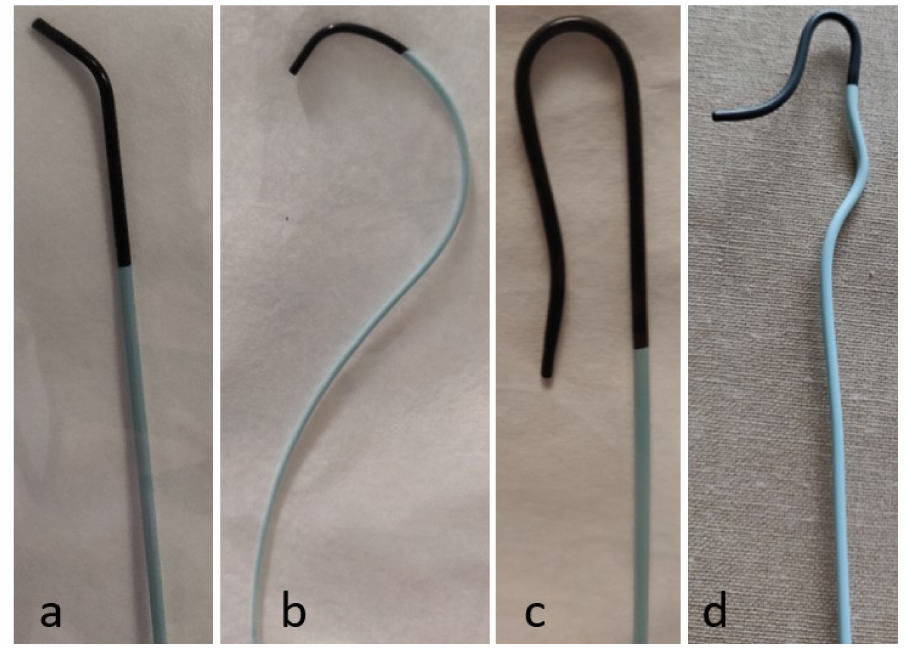
Figure 6. Selective catheters. (a) Berenstein catheter, (b) Cobra 1 cateter, (c) SOS catheter, and (d) Mickelson